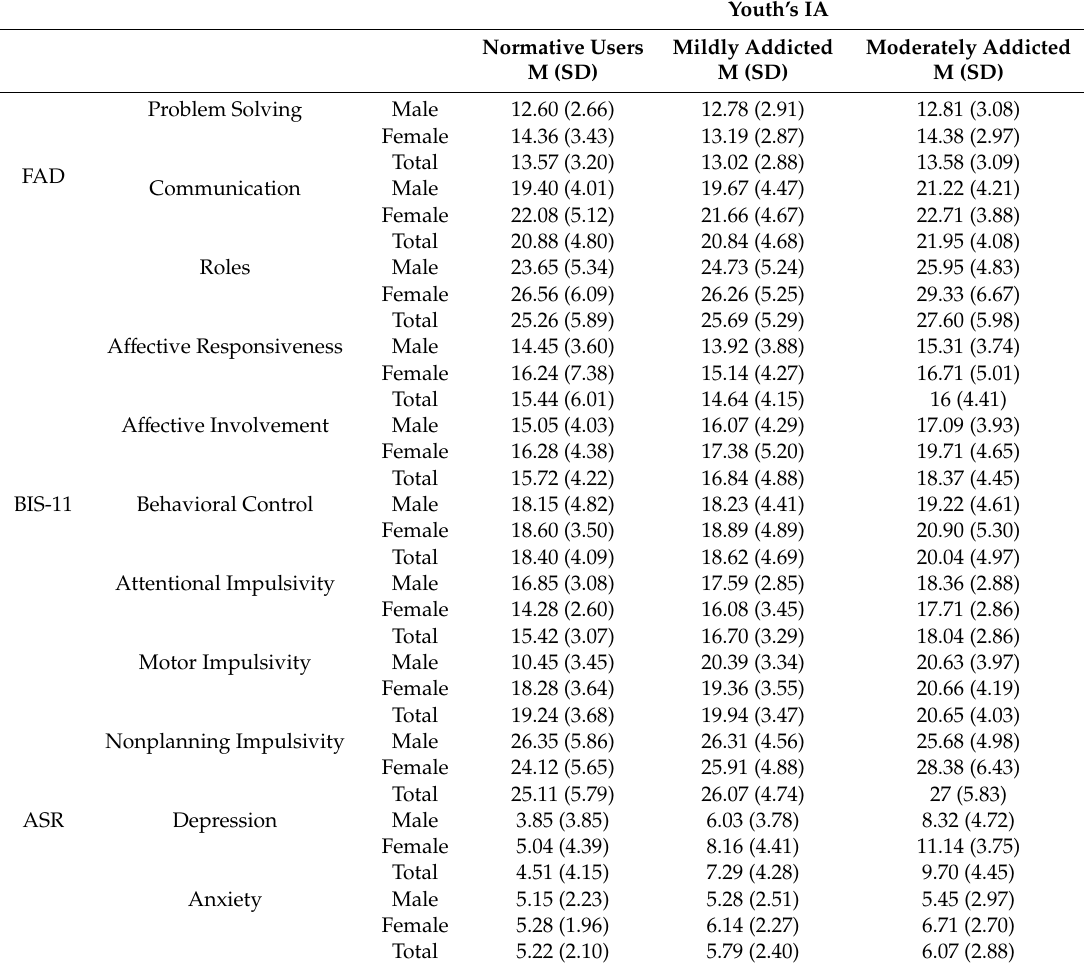
Table Footer:. FAD = Family Assessment Device; BIS-11 = Barratt Impulsiveness Scale; ASR = Adult Self